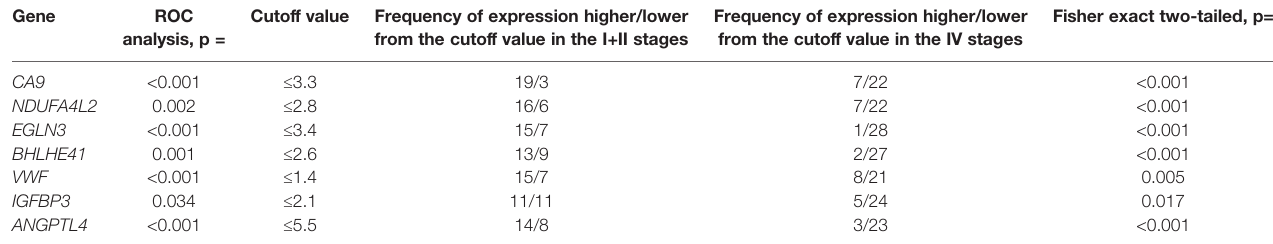
TABLE 3 | Results of ROC analysis of differences in gene expression at stages I, II and IV of ccRCC, frequency of gene expression levels in tumors relative to the cutoff value, and association of expression with tumor stages based on the Fisher exact test.